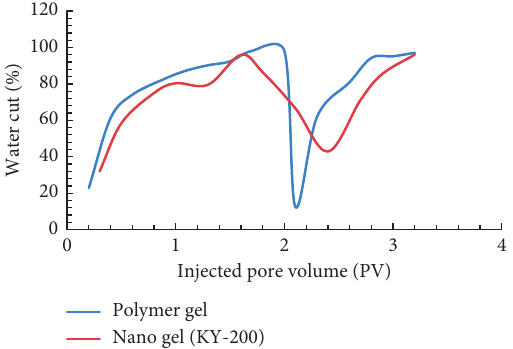
Figure 8: Water cut % vs. injected pore volume,